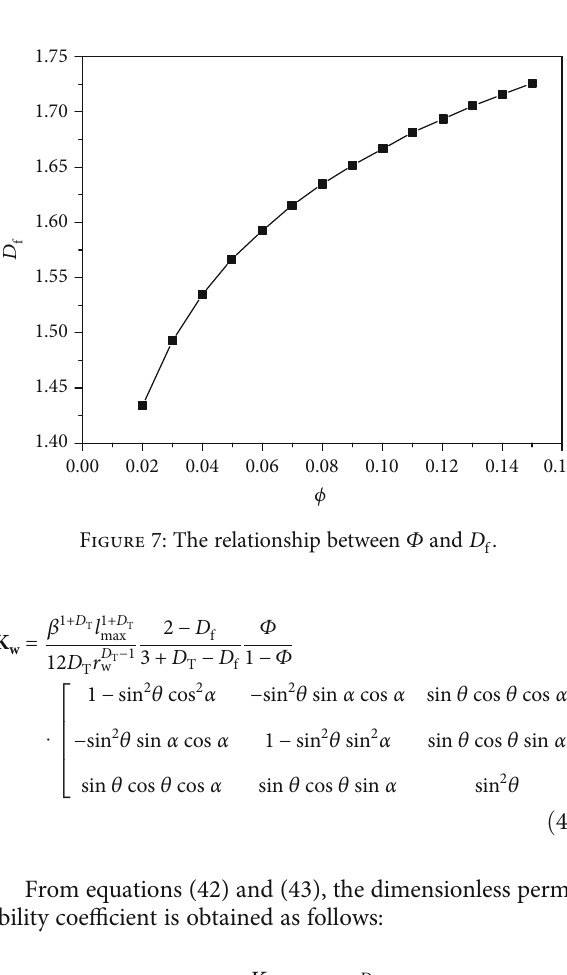
Figure 6: The relationship between K and α = π /2 )